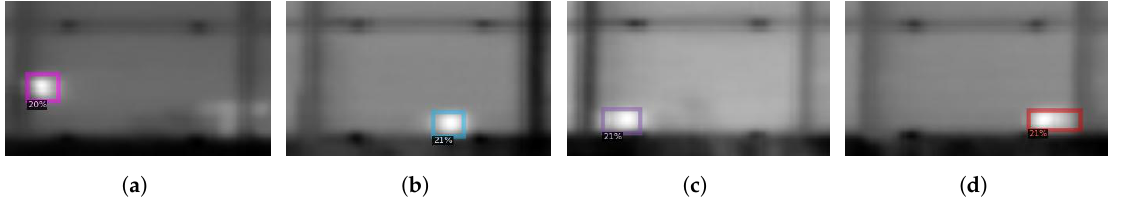
Figure 9. Four different hotspots ( a – d ) detected using our region-based CNN algorithm on the dataset acquired at Omuta,